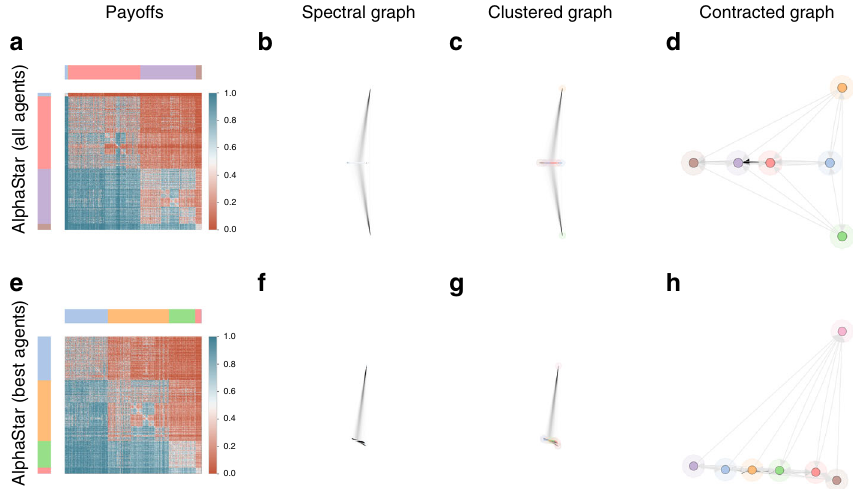
Fig. 7 AlphaStar results, with both the full league and the league with best agents visualized. Spectral analysis of the empirical AlphaStar League game reveals that several key subsets of closely-performing agents, illustrated in d . Closer inspection of the agents used to construct this empirical payoff table reveals the following insights, with agent types corresponding to those detailed in Vinyals et al. 9 : (i) the blue, orange, and green clusters are composed of agents in the initial phases of training, which are generally weakest (as observed in d , and also visible as the narrow band of low payoffs in the top region of the payoff table a ); (ii) the red cluster consists primarily of various, specialized exploiter agents; (iii) the purple and brown clusters are primarily composed of the league exploiters and main agents, with the latter being generally higher strength than the